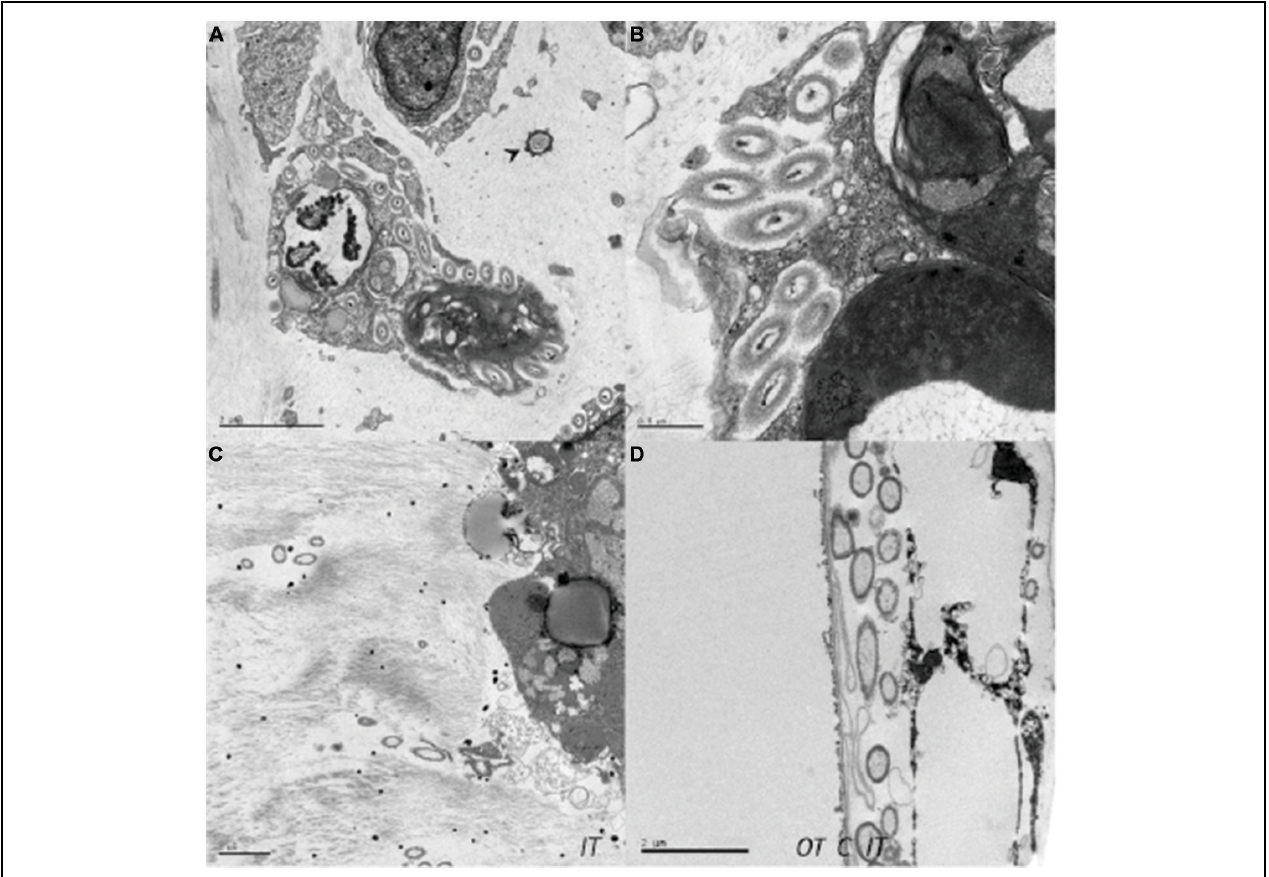
FIGURE 3 | Transmission electron microscopy images of bacterial cells observed in the adult tunic and in the larva of D. fulgens. (A) Rod-shaped bacterial cells docked around ascidian cells and star-shaped bacterium (arrowhead); (B) detail of the bacterial docking; (C) bacterial distribution in the inner tunic of the larva, and (D) bacterial concentration at the larval cuticle edge (C, cuticle; IT, inner tunic; OT, outer tunic). Scale bars represent 2 µ m (A,C,D) and 1 µ m (B)